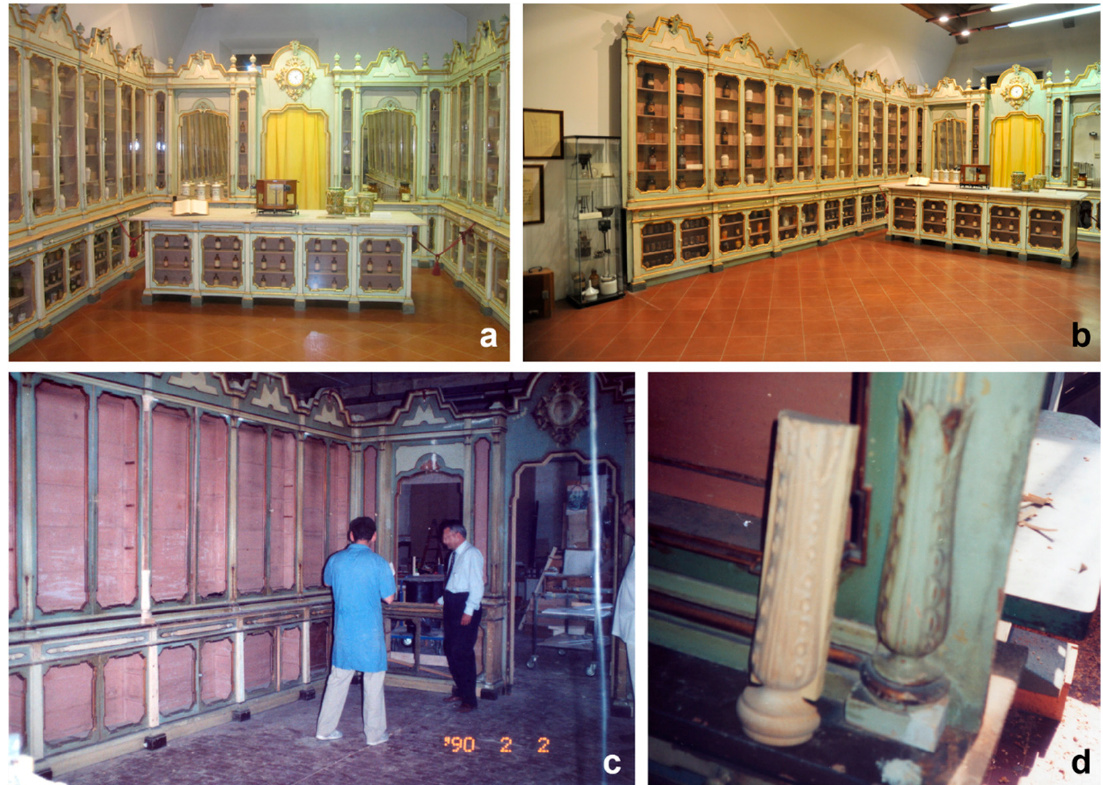
Figure 1. Historical Navarra-Bragliani Pharmacy in Ferrara (Italy): ( a ) overview of the elegant 18th-century furnishing composed of six wood cabinets on each side and a counter with four cabinets and two mirrors on the centre; ( b ) overview of the north side of the pharmacy; ( c ) restoration of the damaged furnishing in the 1990s (courtesy of Conservation Laboratory Maurizi, Montecosaro, Macerata, Italy); ( d ) detail of a reconstructed cabinet decoration (courtesy of Conservation Laboratory Maurizi, Montecosaro, Macerata, Italy).